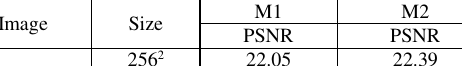
Table 3: The Comparison of PSNR values for different sizes of House Image. Image